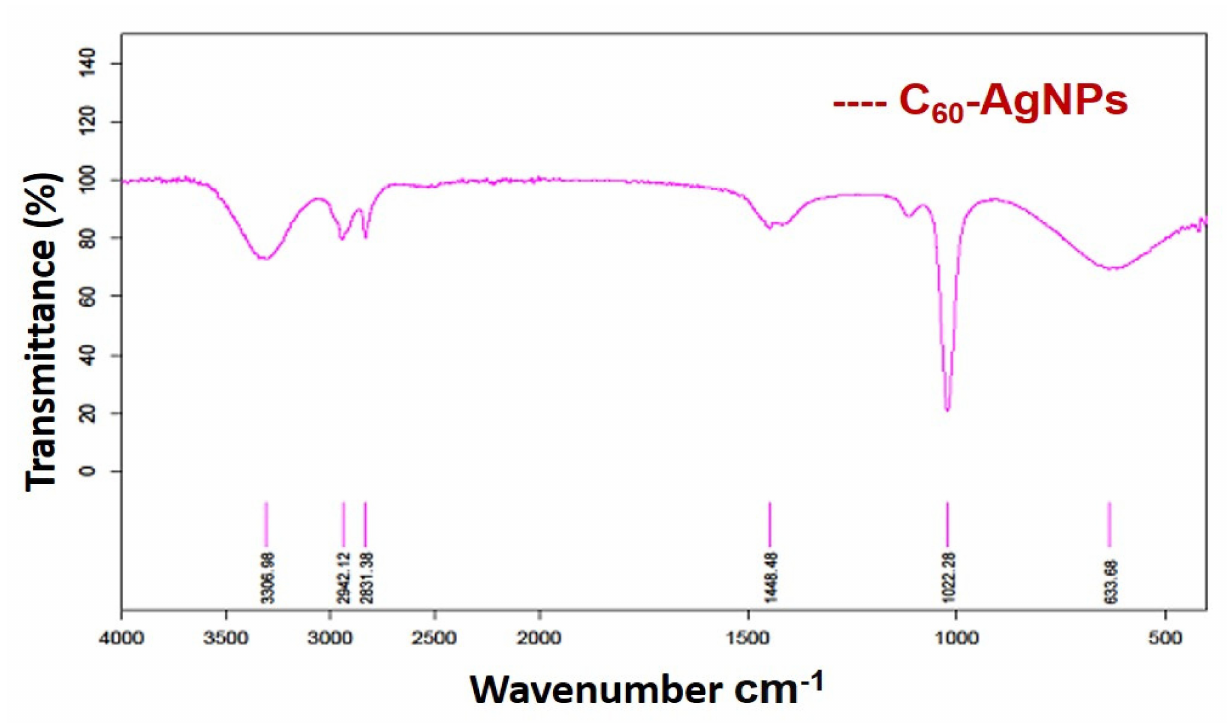
Figure 1. FT-IR of C 60 -AgNP nano-composite indicating different stretching vibrations and associated functional